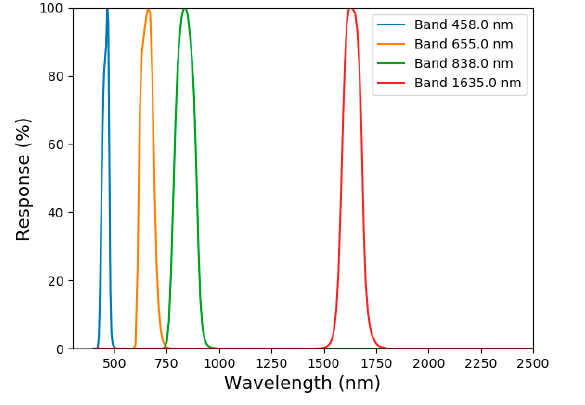
( g ) Spectral response for VGT2 sensor on a (300,2500) nm range Figure 5. Spectral response on the (300 nm, 2500 nm) interval for NOAA-X/AVHRR and VGT-2 sensors. Only NOAA: ( a )—7, ( b )—9, ( c )—11, ( d )—14, ( e )—16, and ( f )—17 are considered, and ( g ) VGT2 in C3S.